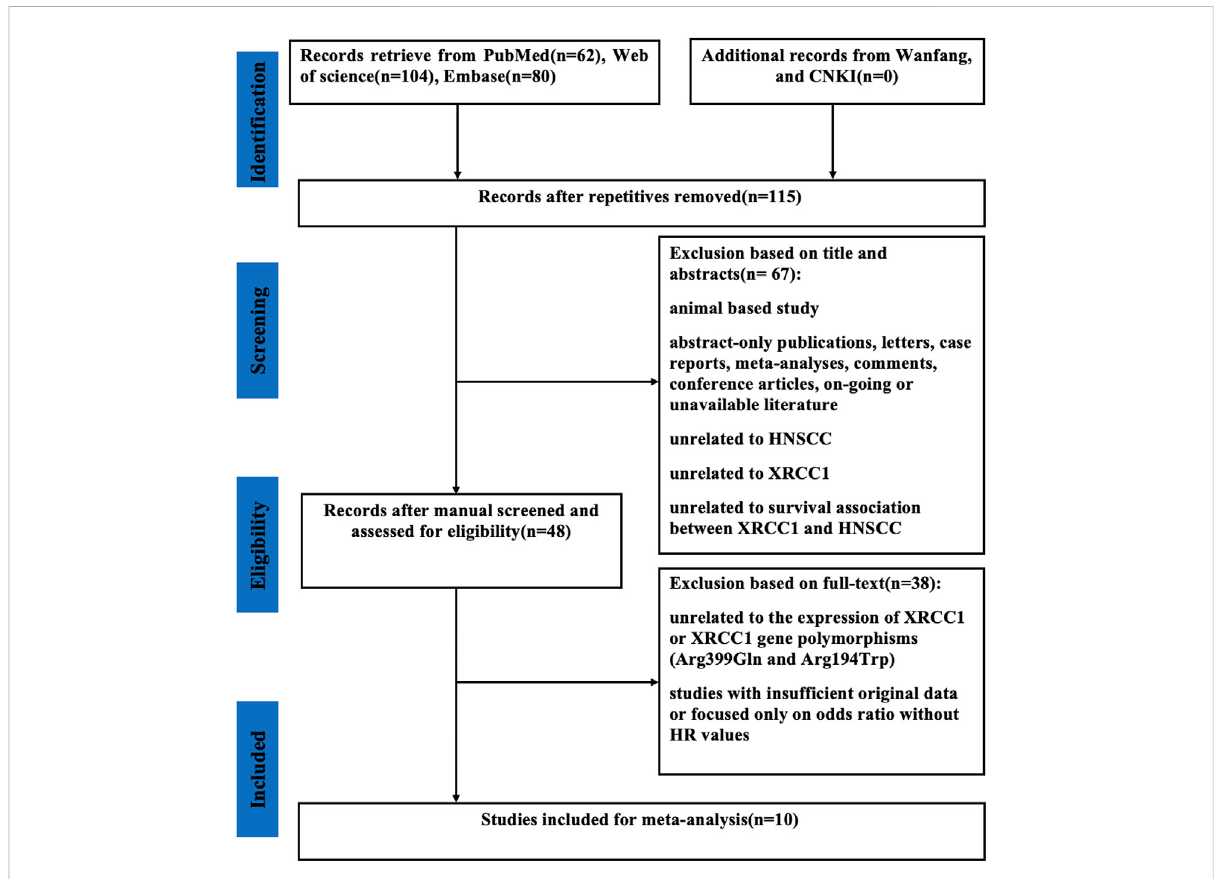
FIGURE 1 Flowdiagramoftheselectionofrelevantstudiesincludedinthemeta-analysis.CNKI,ChineseNationalKnowledgeInfrastructure;XRCC1,X-ray repair cross-complementary group 1; HNSCC, head and neck squamous cell carcinoma; HR, hazard